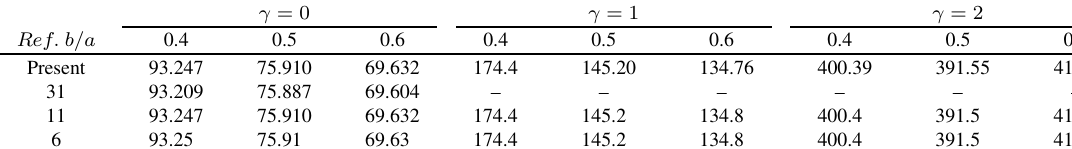
Table 4 Comparison of critical buckling loads N ∗ cr for homogeneous ( μ = β = 0 ) isotropic C-C plate, p = 1